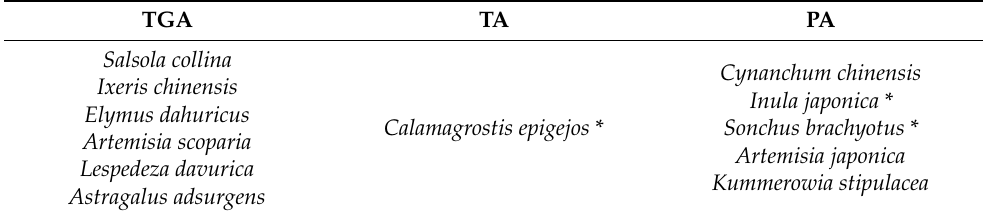
Table 3. Indicator species in the three subareas.